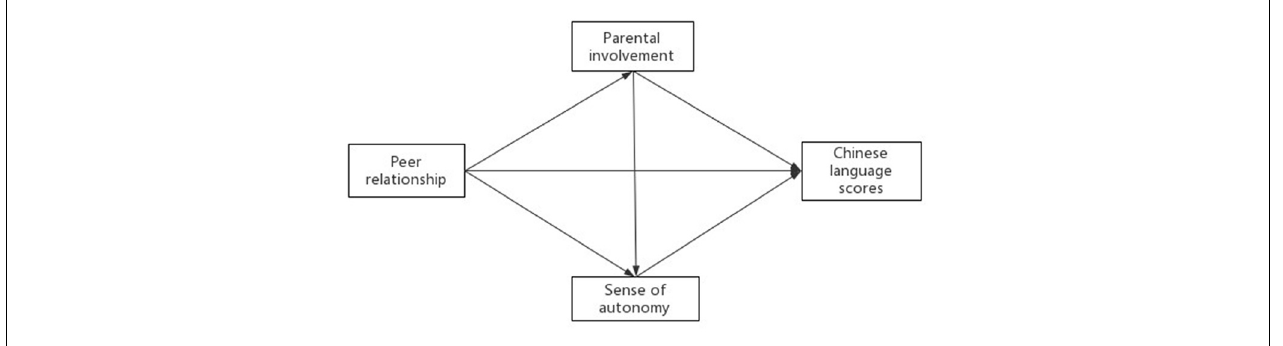
FIGURE 1 | A hypothetical model of the relationship between variables. Peer relationship’s influence on Chinese language scores through Parental involvement and Sense of